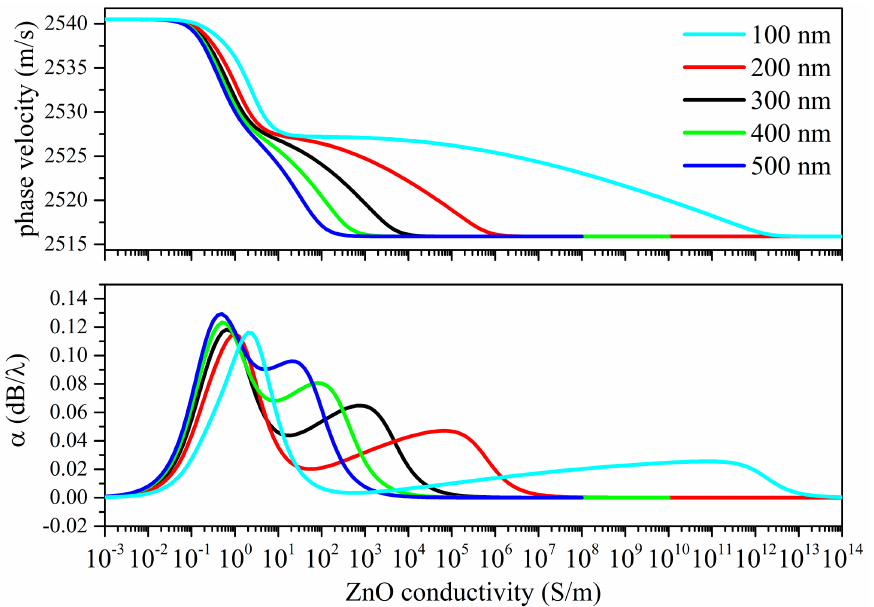
Figure 8. Rayleigh wave phase velocity and propagation loss vs. conductivity curves under top illumination; the penetration depth is the running parameter.